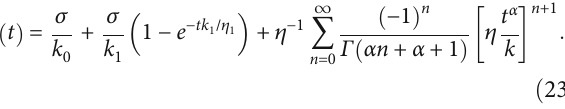
Figure 5: A fractional rheological model based on the Kelvin